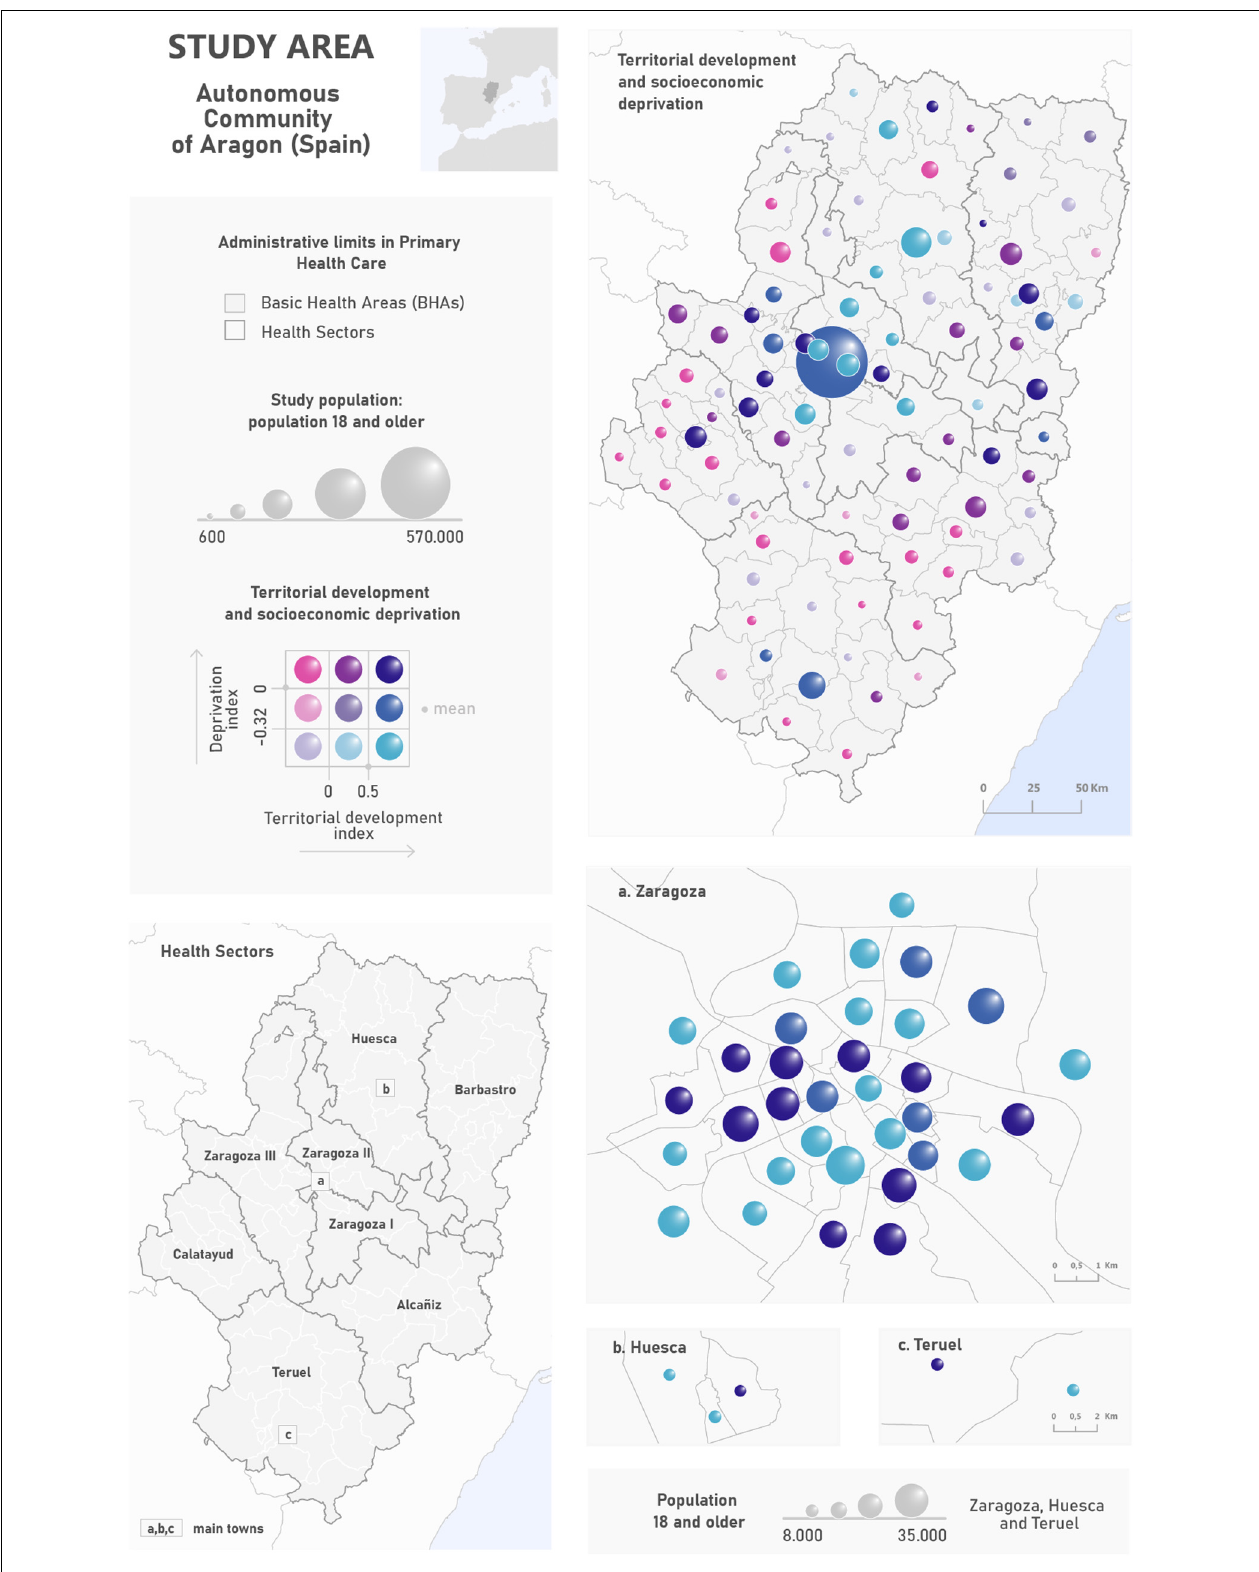
FIGURE 1 | Study area and spatial distribution of the privation and territorial development indexes by BHA.